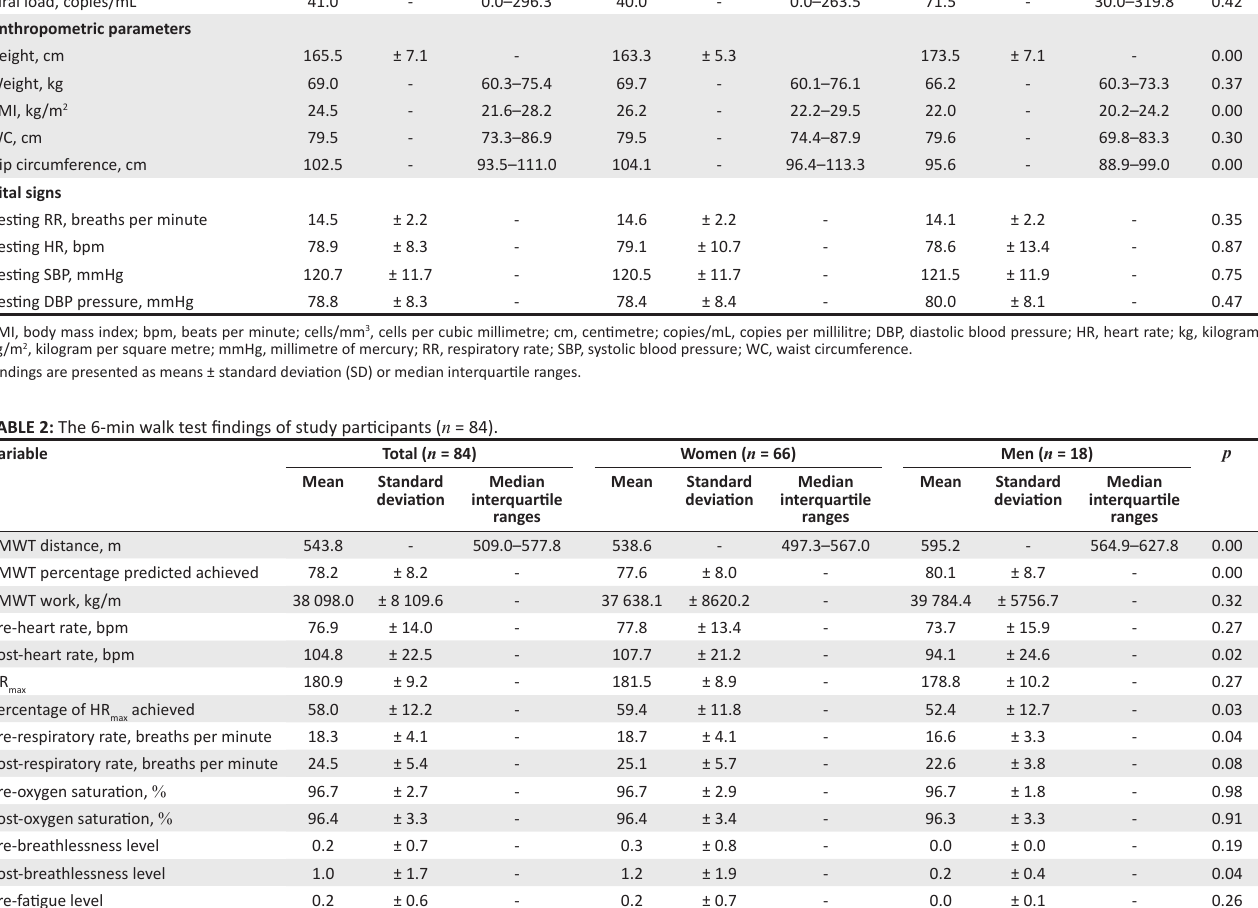
TABLE 1: Characteristics of study participants ( n =